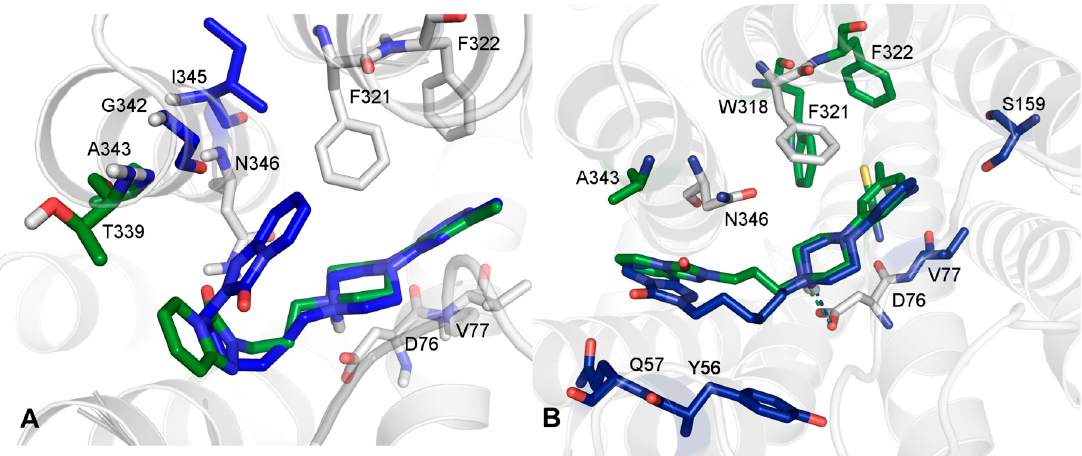
Figure 2. Two considered binding modes of trazodone (blue) and 10e (green) in the homology model of serotonin receptor 5-hydroxytryptamine (5-HT 1A ). Only key residues of the receptor are marked as sticks, where those employed in the binding of both are uncolored and those specific in the ligands are colored.